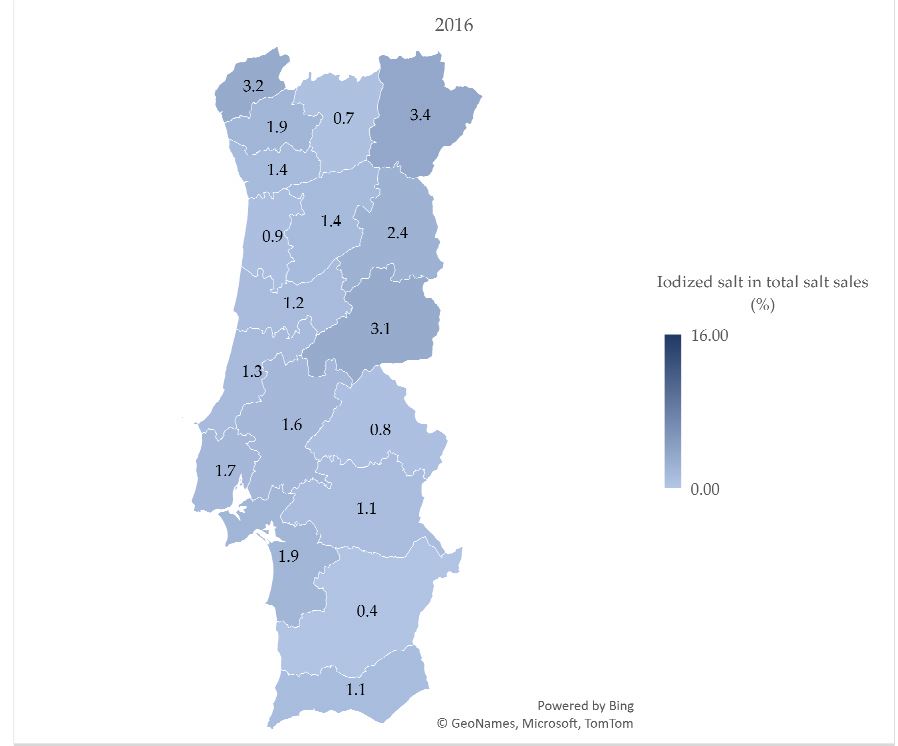
Figure 2. Percentage of iodized salt in total salt sales by district in 2016.